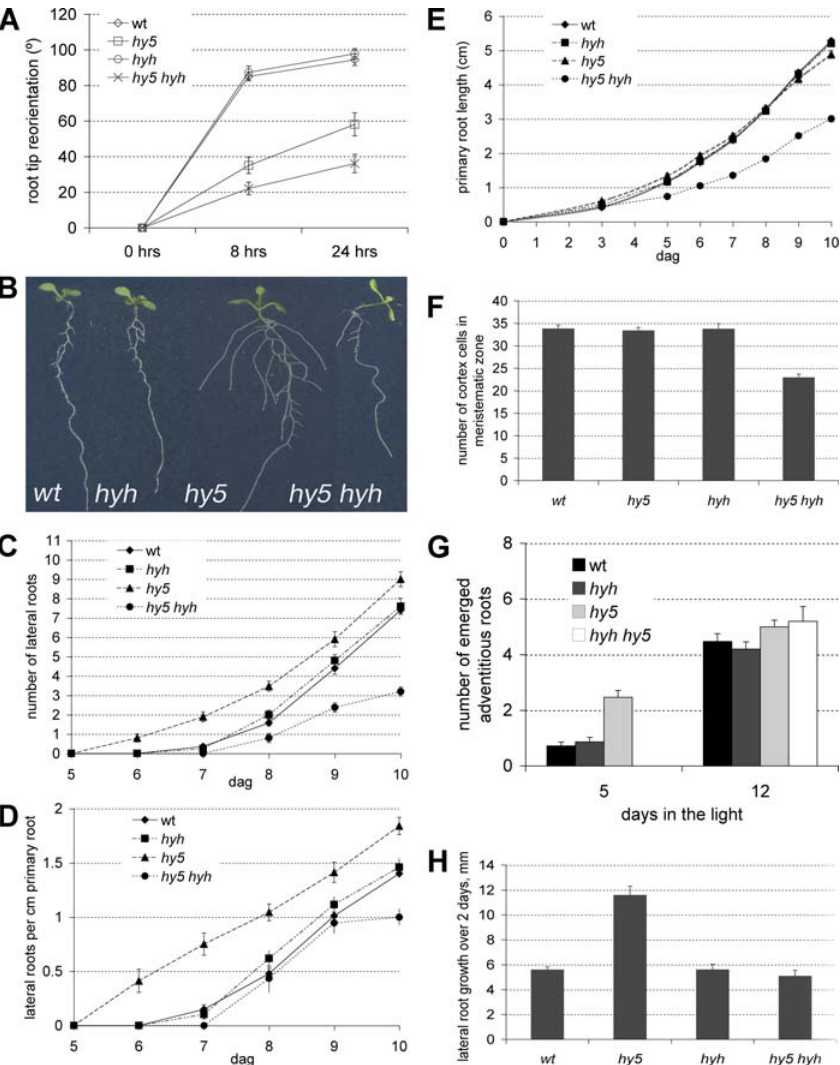
Figure 3. Root System Phenotypes in hy5 hyh Double Mutants Phenotypic analyses of wild-type, hy5 , hyh, and hy5 hyh seedlings. (A) Gravitropic response of the root tip (curvature). Time points refer to time after change of the gravity vector by 90 degrees. (B) Representative seedlings at 8 dag. (C) Progression of lateral root emergence. (D) Progression of primary root growth of the seedlings in (C). (E) Lateral root density of the seedlings in (C) and (D). (F) Progression of adventitious root formation from the hypocotyl of 5-d-old dark-grown seedlings after shift into the light for the indicated number of days. (G) Lateral root growth rate in the different genotypes, recorded between 8 and 10 dag. (H) Quantification of primary root meristem size. Error bars represent standard error of the